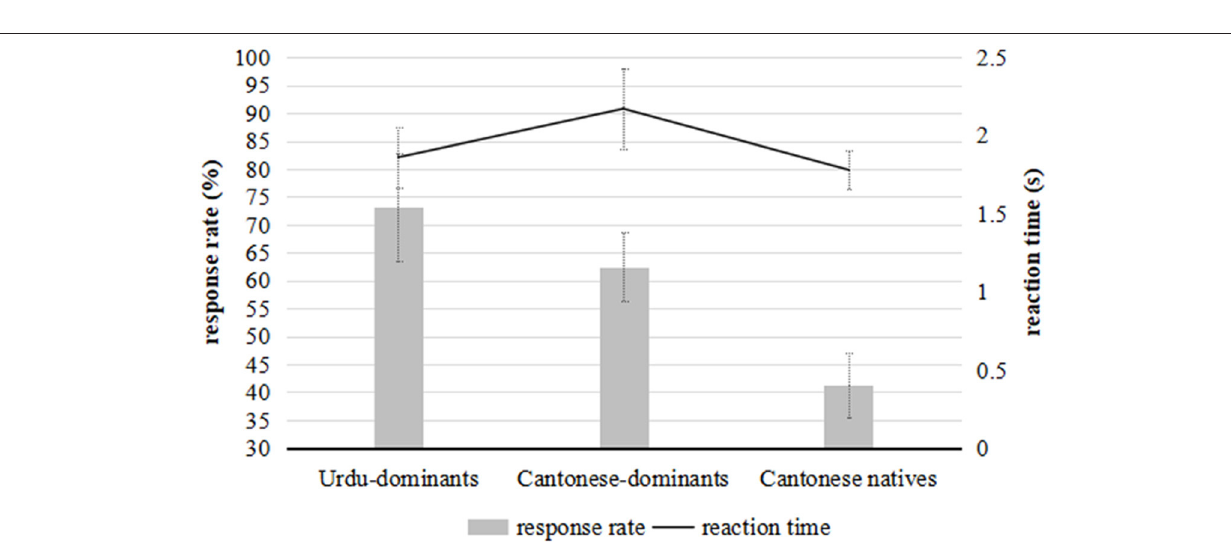
FIGURE 4 | The mean accuracy/response rates (gray bars) and reaction time (dark line) for the bilinguals and Cantonese native speakers in the task of segment-or-tone. The minor y-axis shows the response time and the main y-axis illustrates the response rate. The error bars show 1/2 of SD